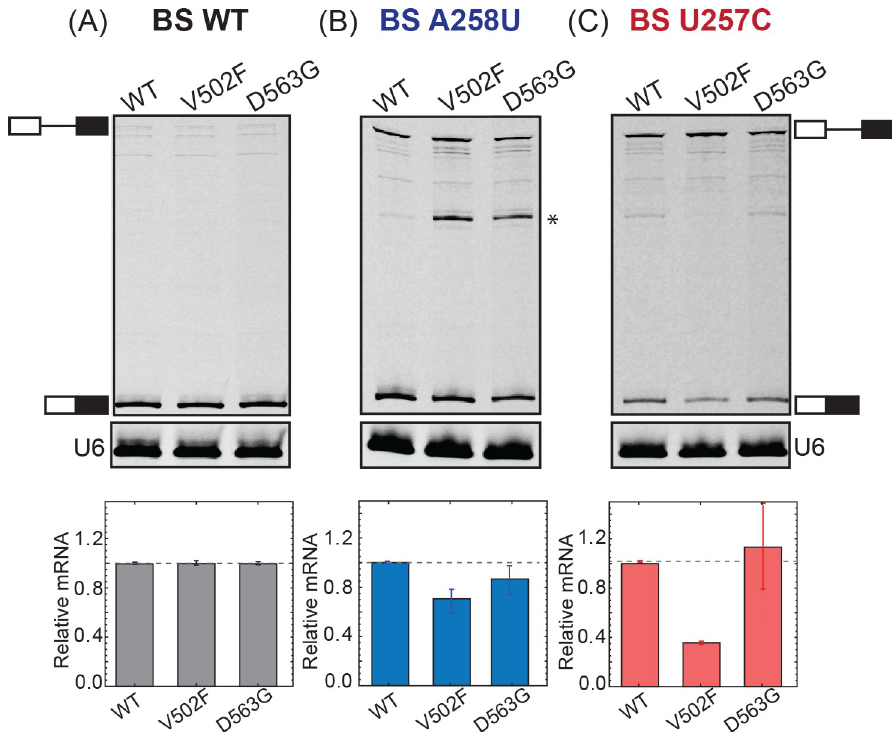
Fig 3. Primer extension analysis of ACT1-CUP1 splicing. (A-C) Primer extension analysis of Hsh155 WT and LBU- mutant strains carrying ACT1-CUP1 reporter plasmids. Top panel, PAGE analysis of the primer extension products. The pre-mRNA and mRNA bands are marked. Middle panel, primer extension products from U6 snRNAs analyzed on the same gel as in the top panel and used as an internal control. Bottom panel, quantification of the primer extension results. Each bar graph represents the average and standard deviation of the fraction mRNA [mRNA/ (mRNA+pre-mRNA)] observed from three replicates. The asterisk represents a band amplified in the primer extension reaction but not identified. The original image for the gel is provided in S1 Raw